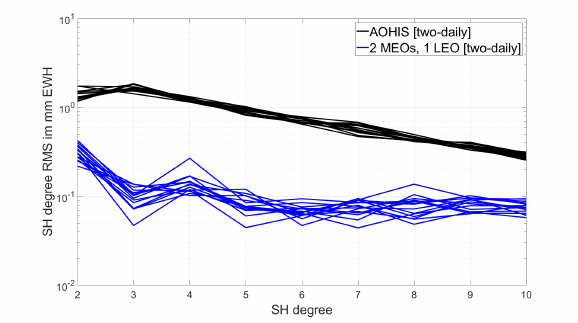
Fig. 9. Degree RMS of 2-daily gravity field solutions resolved up to SH degree 10. The full AOHIS signal is included in the observations, and recovered in the retrieval process. For details see text.